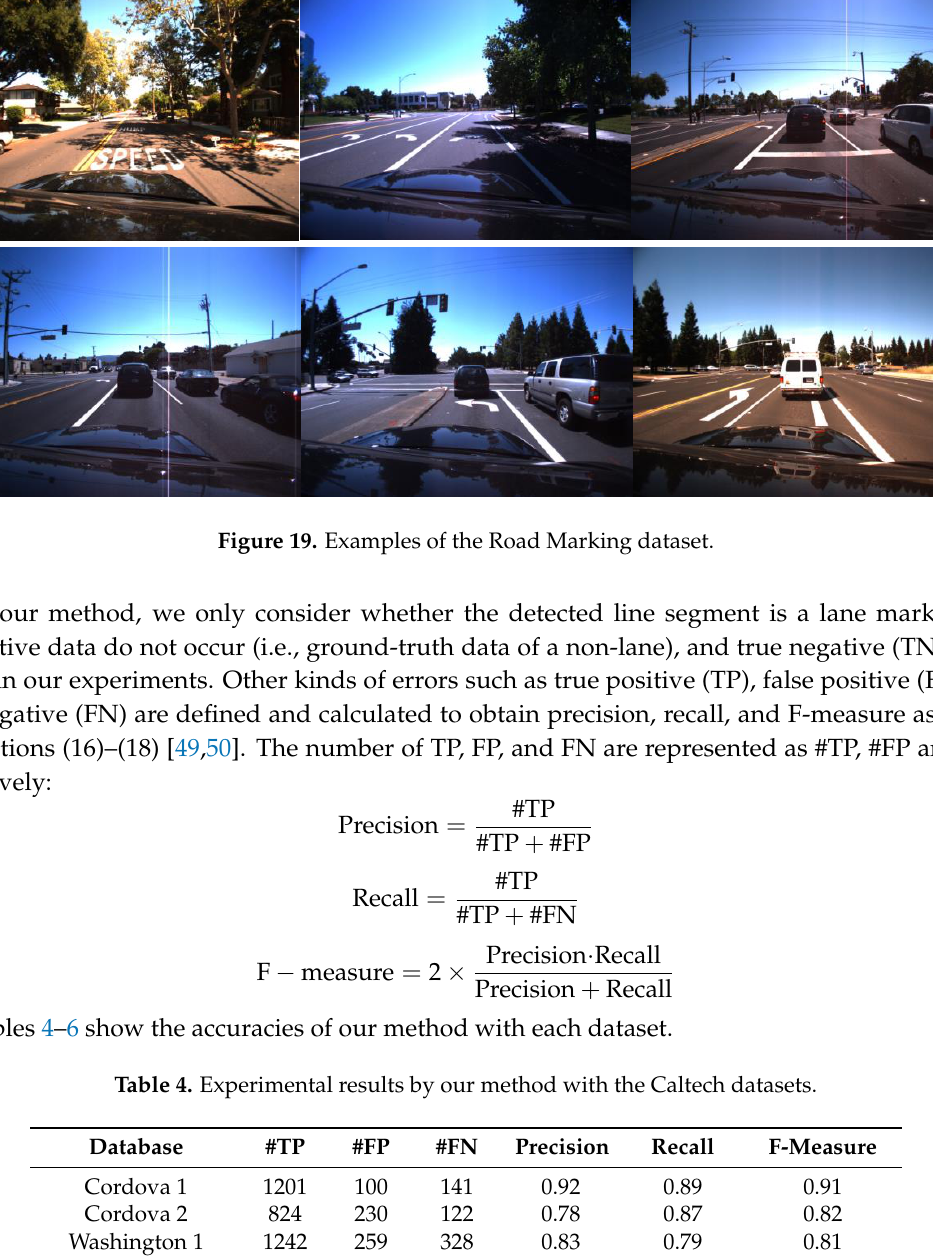
Figure 18. Examples of the SLD dataset.